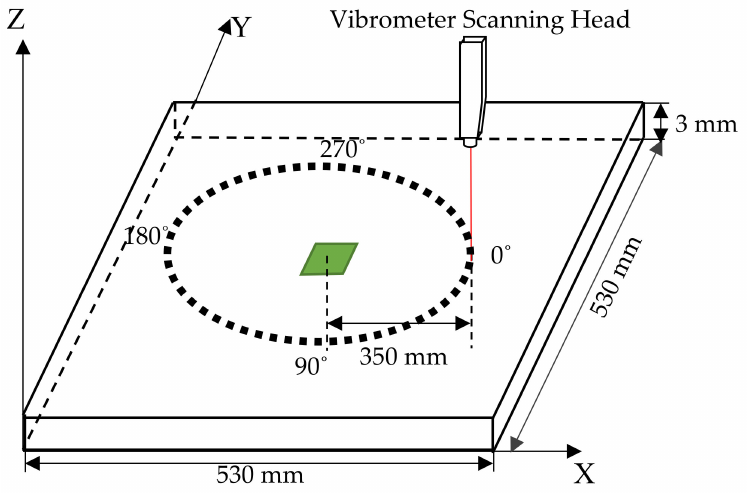
Figure 8. Geometry of scan to measure GW directivity